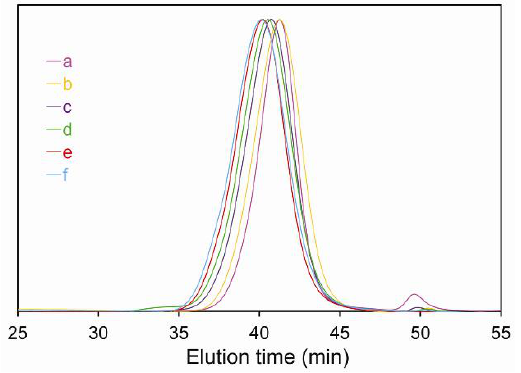
Figure 4. Chromatograms (RI) of DEGMA polymers obtaining by RAFT polymerization at different reaction times [ M n (g mol − 1 ), Đ ]: ( a ) 20 min (22,660, 1.07), ( b ) 40 min (24,000, 1.13), ( c ) 60 min (30,530, 1.15), ( d ) 80 min (34,570, 1.11), ( e ) 100 min (32,840, 1.09), and ( f ) 120 min (33,760, 1.10).